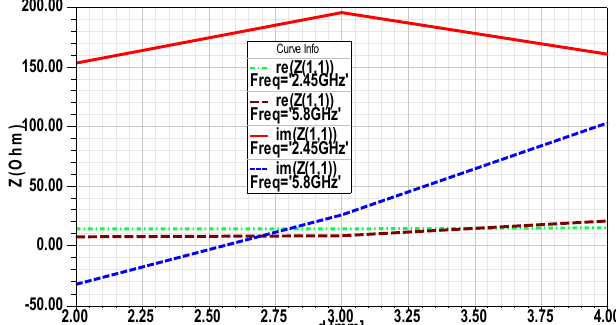
Fig. 7. Input impedance with different width g